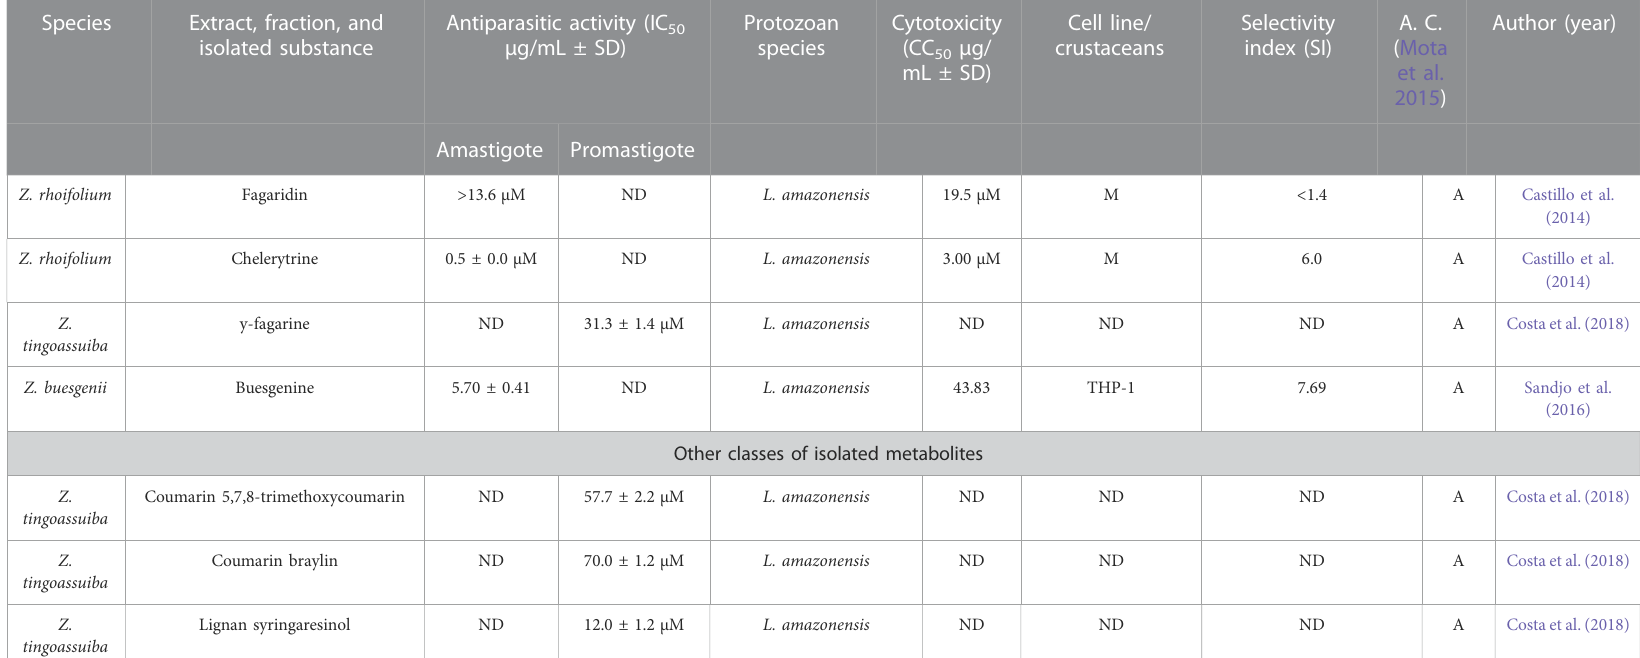
TABLE 5 ( Continued ) In vitro antiparasitic activity against the genus Leishmania